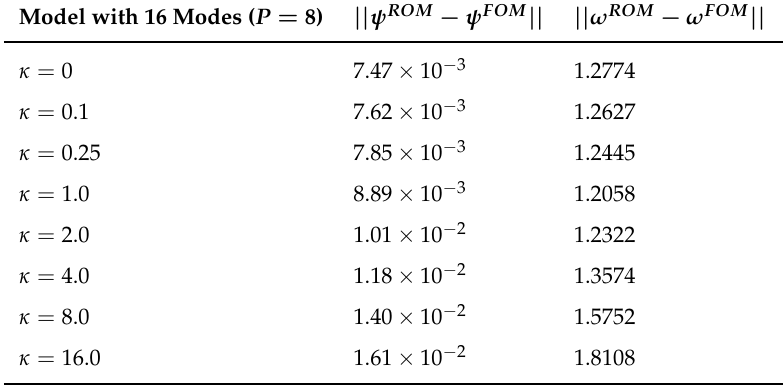
Table 3. Root-mean-squares error at time t = 4 between the partitioned ROM ( P = 8, R = 16) and FOM in order to demonstrate the sensitivity with respect to the additional stabilization through κ at Re =